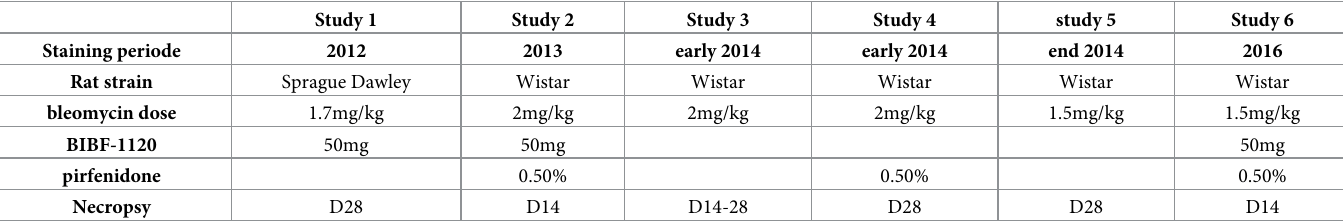
Table 1. Animal studies